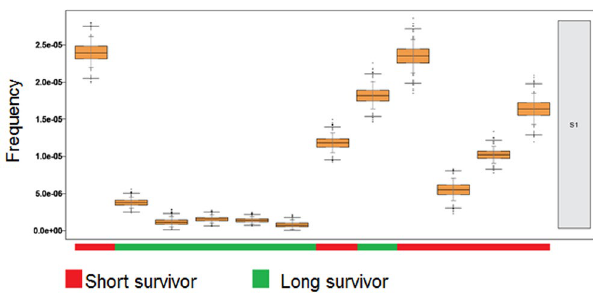
Figure 5. Association of the mutational signature S1 with short overall survival. Contribution of each sample to the mutational signature S1. Sample identifiers have been